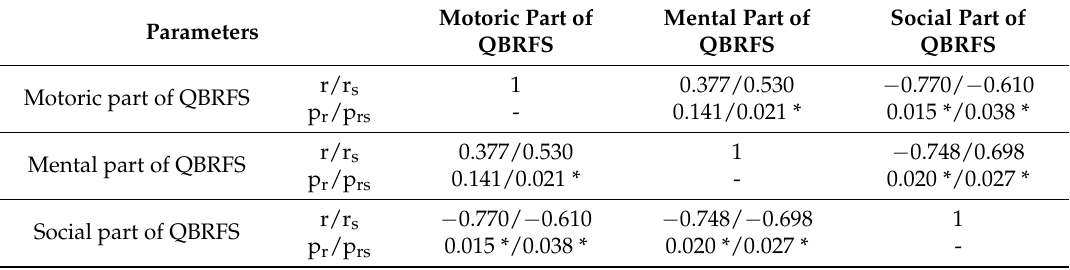
QEIFS—the questionnaire of benefits of recreational figure skating, r—Pearson’s correlation, r s —Spearman’s correlation, p r —significant level of Pearson’s correlation index, p rs —significant level of Spearman’s correlation index, * Correlation is significant at the 0.05